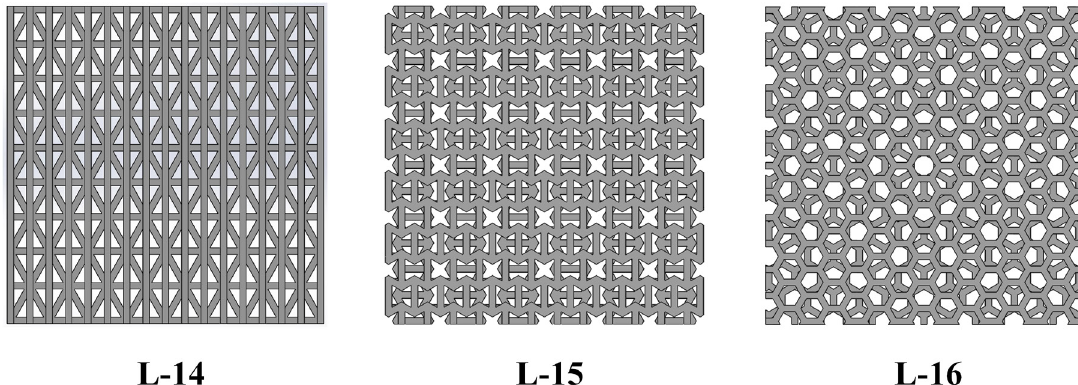
Figure 16. Plane diagrams of specimens with different honeycomb lattice structures.